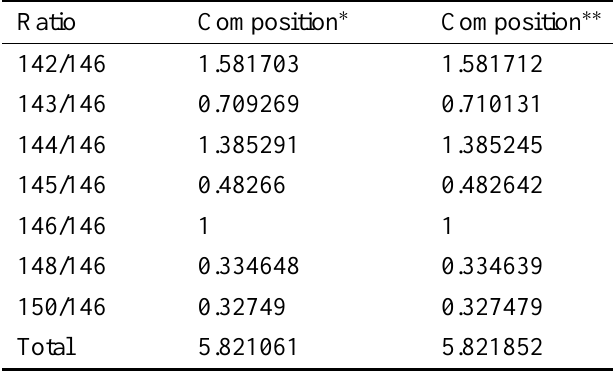
Isotopic Ratios for natural Nd used for Isotope Dilution